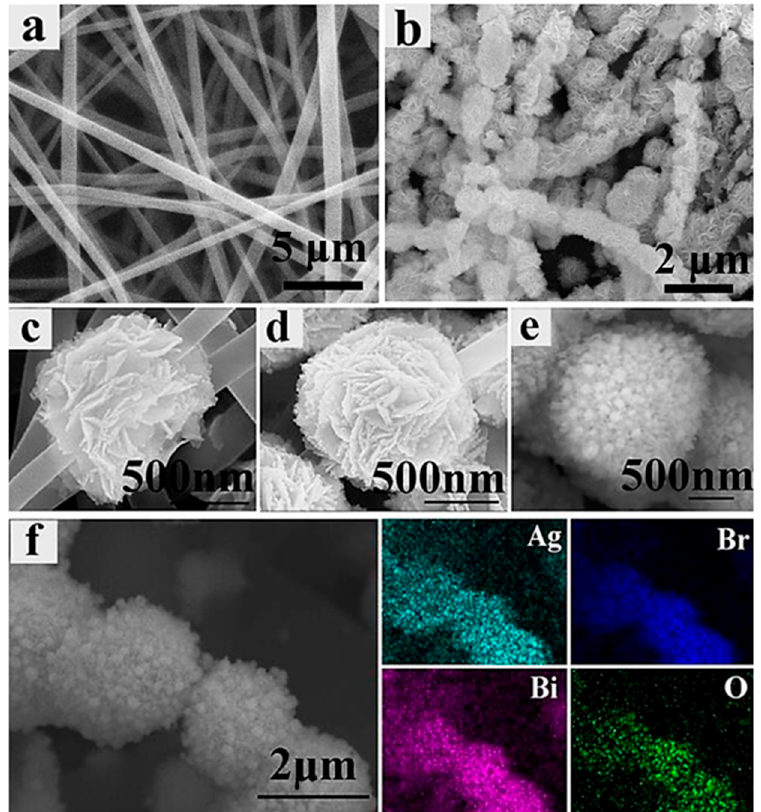
Figure 3. Scanning electron microscopy (SEM) images of ( a ) PAN nanofibers (NFs) and ( b ) BiOBr / PAN CMs; SEM images of BiOBr or AgBr / BiOBr nanostructures in ( c ) BiOBr / PAN CMs, ( d ) AgBr / BiOBr / PAN CMs-1, and ( e ) AgBr / BiOBr / PAN CMs-2; ( f ) SEM images of AgBr / BiOBr / PAN CMs-2 (left) and the corresponding elemental maps (right) of Ag, Br, Bi, and O.